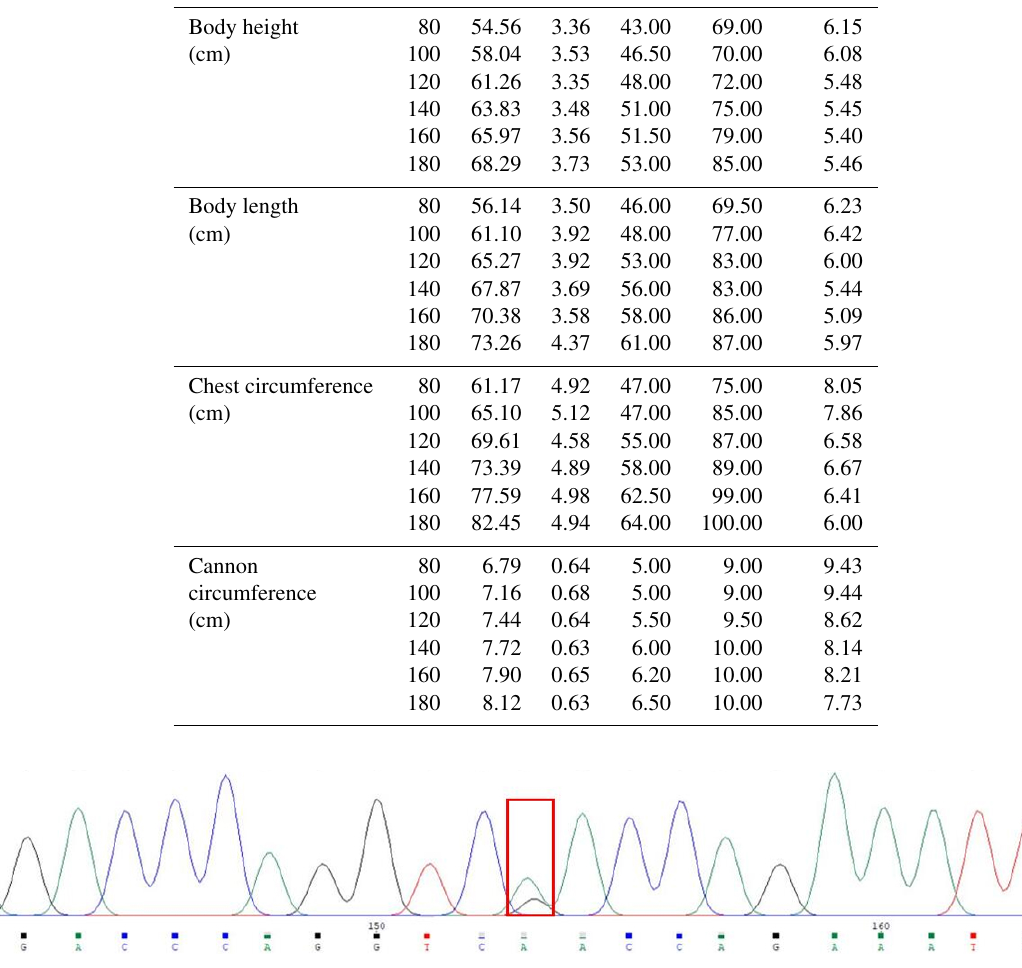
Figure 3. Sequencing peak map of MAP3K5